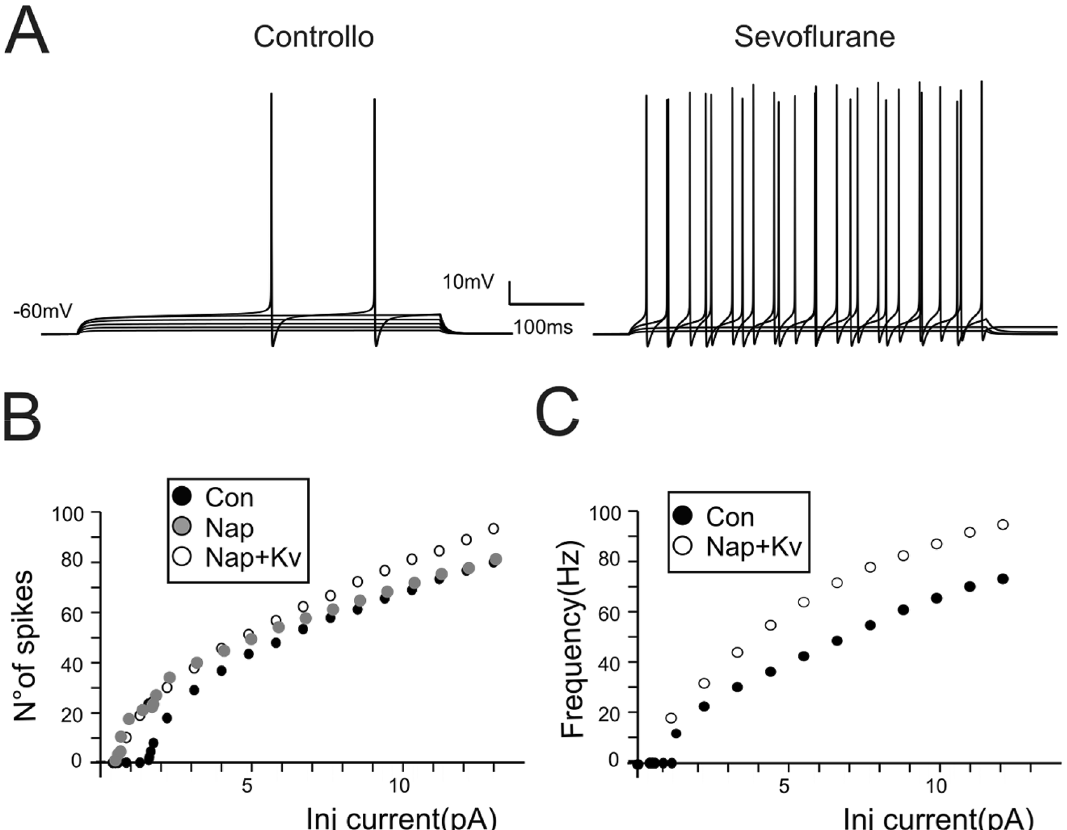
Figure 7. Simulation of GrCs intrinsic excitability. ( A ) Simulated GrC voltage responses to current injections (1 pA/step) in control conditions (left panel) and mimicking the presence of sevoflurane (right panel) by increasing the persistent sodium conductance (Nap) and voltage dependent potassium conductance (Kv). Note that, as observed experimentally, less injected current is needed to generate action potentials with sevoflurane. Also note the increased number of elicited spikes and the reduced firing threshold in the presence of sevoflurane. ( B ) The plot shows the number of spikes generated in response to current injection in control, when Nap is increased, and when both Nap and Kv are increased. Note that simulations with increased Nap tend to saturate more rapidly than those obtained when both Nap and Kv are increased. ( C ) The plot shows the relationship between the current injected and the average firing frequency in control condition and when both Nap and Kv are